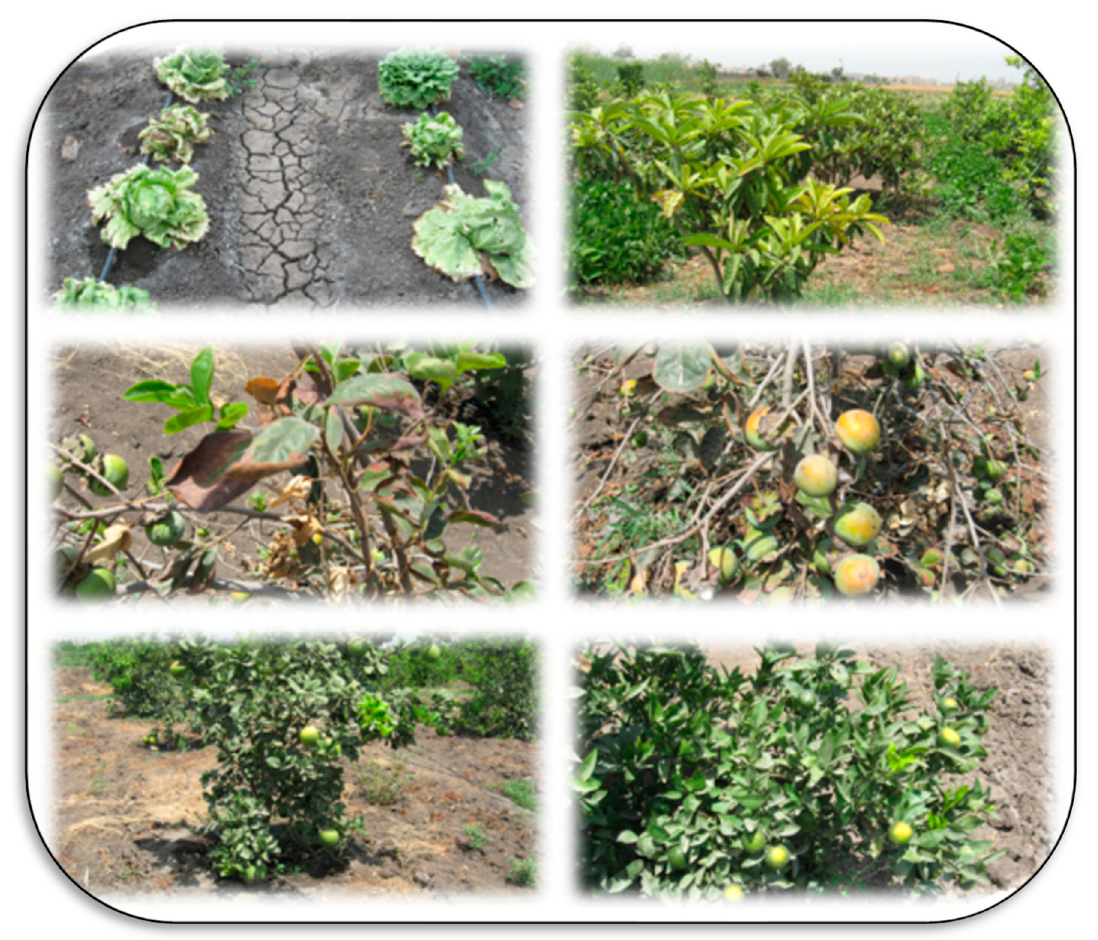
Figure 7. Production of horticultural crops under arid climatic zones and salinity stress in salt-affected soils at the experimental farm of Kafrelsheikh University (Egypt). Many crops physiological and nutritional problems (mainly nutrient imbalances, dehydration, disease pressure due to decreased resistance) can be seen on the cultivated crops from top to bottom; lettuce, sugar-apple tree ( top photos), persimmon (the middle photos), and citrus ( lower photos). Photos by El-Ramady.